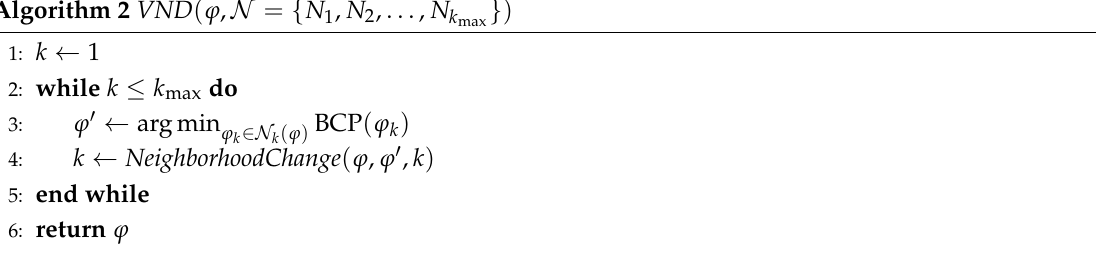
Algorithm 2 VND ( ϕ , N = { N 1 , N 2 , . . . , N k